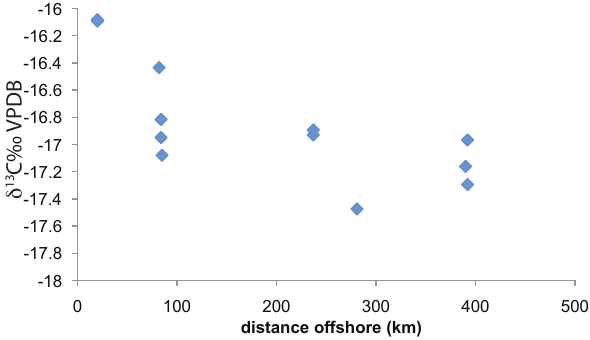
Figure 7. The relationship between δ 13 C of coral gorgonin and dis- tance from shore indicates declining δ 13 C values offshore ( n = 12 coral samples; points represent average values for outer 15mm of gorgonin). This relationship has been previously observed in zoo- plankton and nekton up to 70km offshore (Miller et al.,